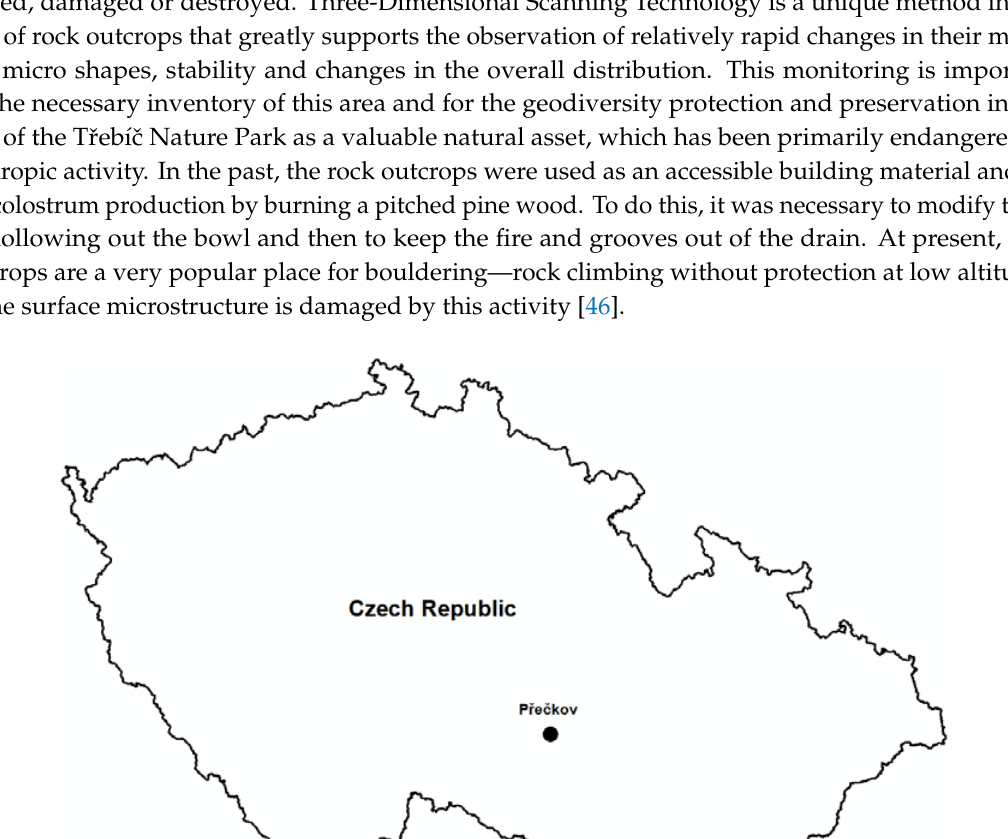
Figure 2. Localization of boulders. In order to compare remote sensing methods, it was necessary to select suitable and easily accessible rock outcrops of a size that would be easy to capture using a smartphone (Figure 2). The